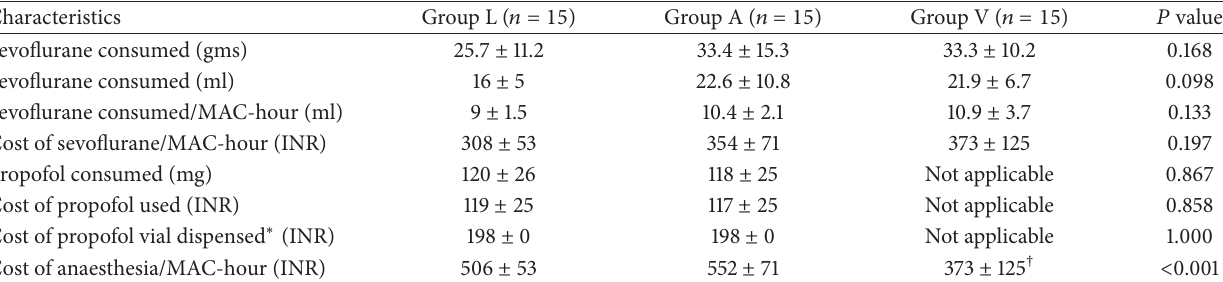
Table 3: Consumption and cost of sevoflurane and propofol.